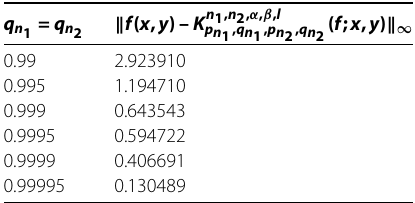
Table 2 The errors of the approximation of K n 1 , n 2 , α , β , l p = p n = 1–1/10 15 , l = 1, α = 3, β = 2 and different values of q n p n 1 2